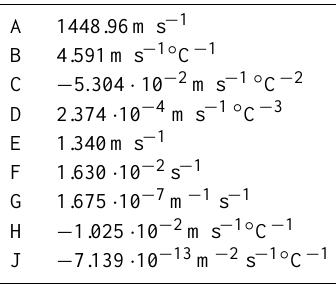
Table 1. Numerical coefficients of the MacKenzie sound speed for- mula (1981)